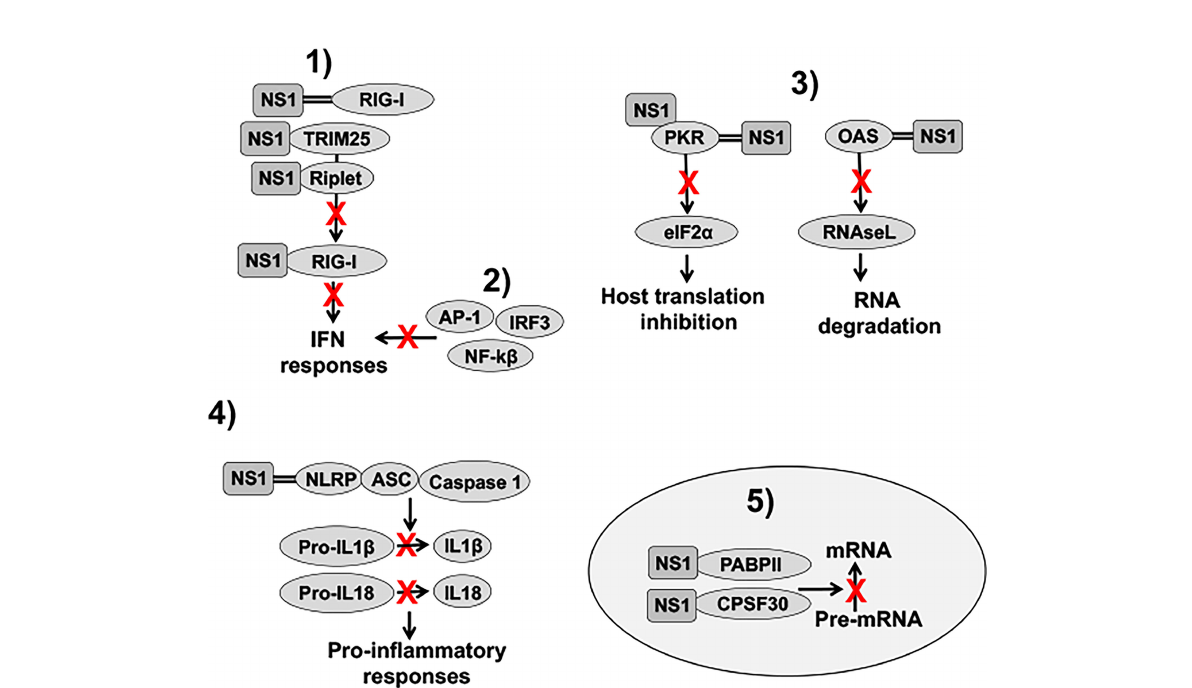
FIGURE 4 Role of NS1 in counteracting IFN responses. 1 ) IAV NS1 decreases RIG-I activation, and therefore, IFN responses, through the sequestration of dsRNA (represented with two parallel lines), or by interaction with RIG-I, TRIM25 or Riplet, resulting in the suppressed ubiquitination